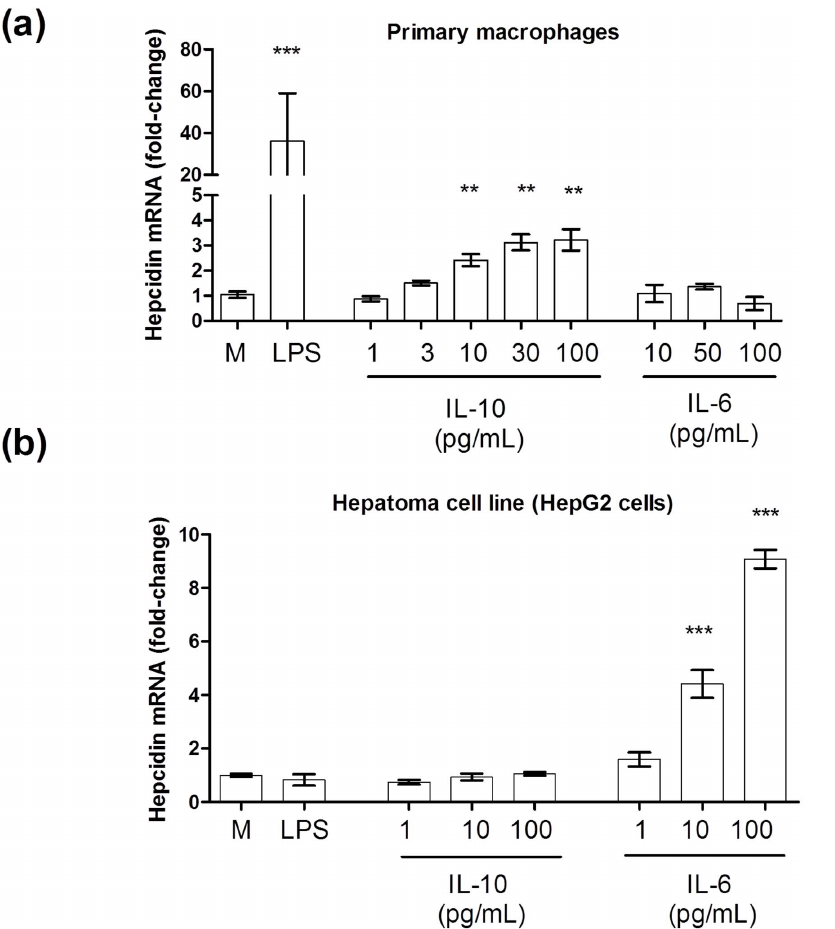
Figure 2. Effect of IL-10 and IL-6 on the regulation of hepcidin in (a) primary macrophages and (b) HepG2 cells. Data show fold- increase relative to mRNA in media control. Error bars indicate standard error of the mean. Bar plots show data from at least 3 independent experiments. ** P , 0.01, *** P , 0.001 (Mann-Whitney test, compared with Media control).